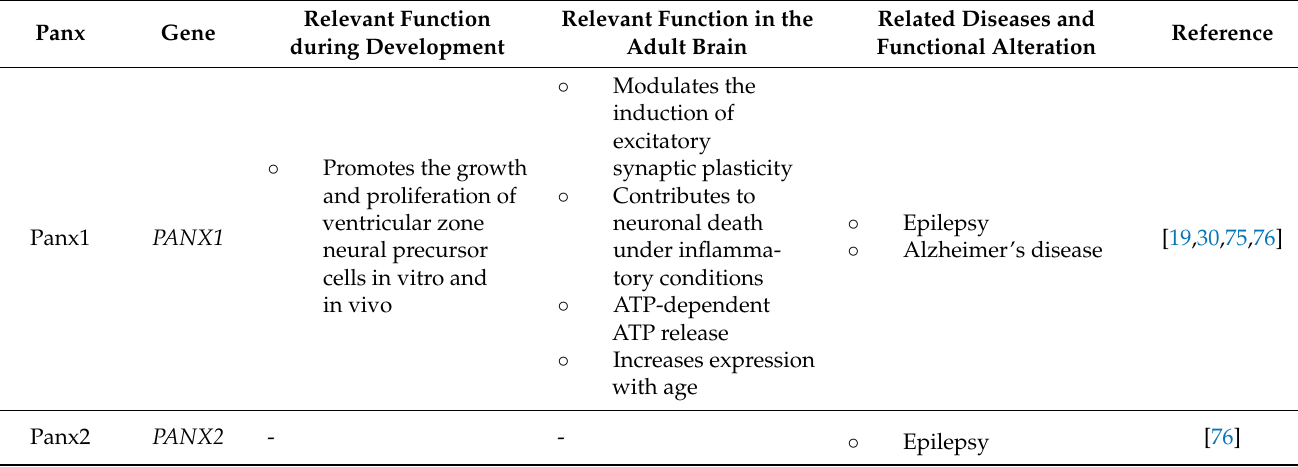
Table 2. Functions of Panxs during development, in the adult brain, and related neurological